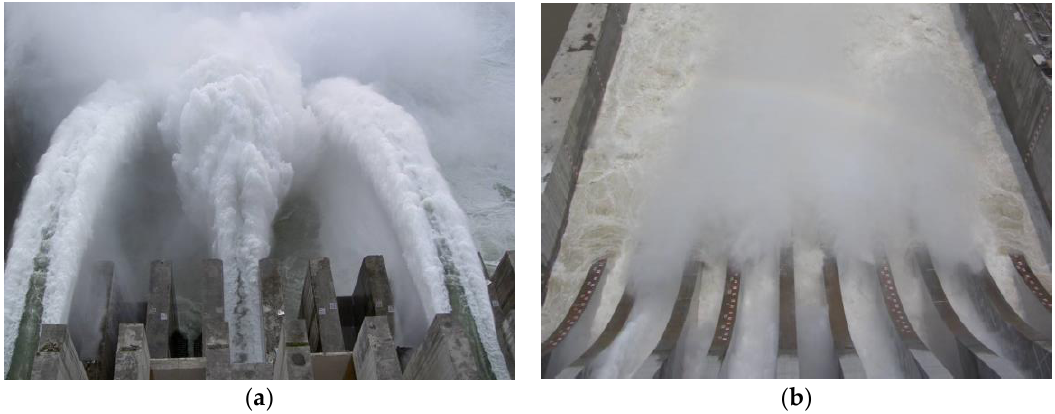
Figure 1. Air water flow in three-dimensional aerators: ( a ) Three Gorges Project; ( b ) Xiang Jia-Ba Project.